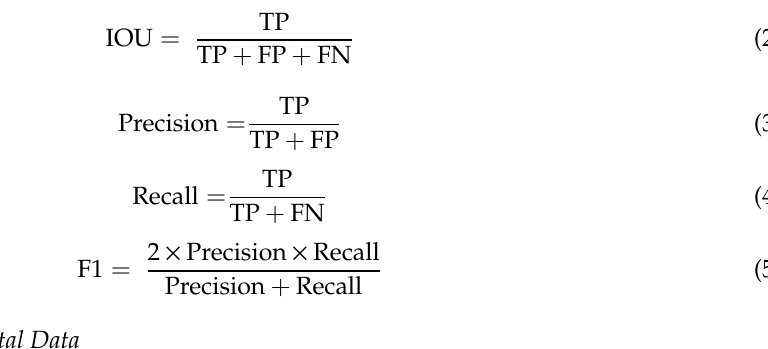
VV Figure 12. Sentinel-1 dual polarization imaging.